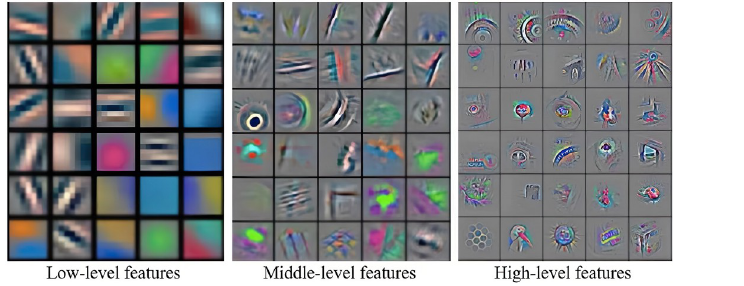
Fig 1. Object features extracted by neural networks with different depths